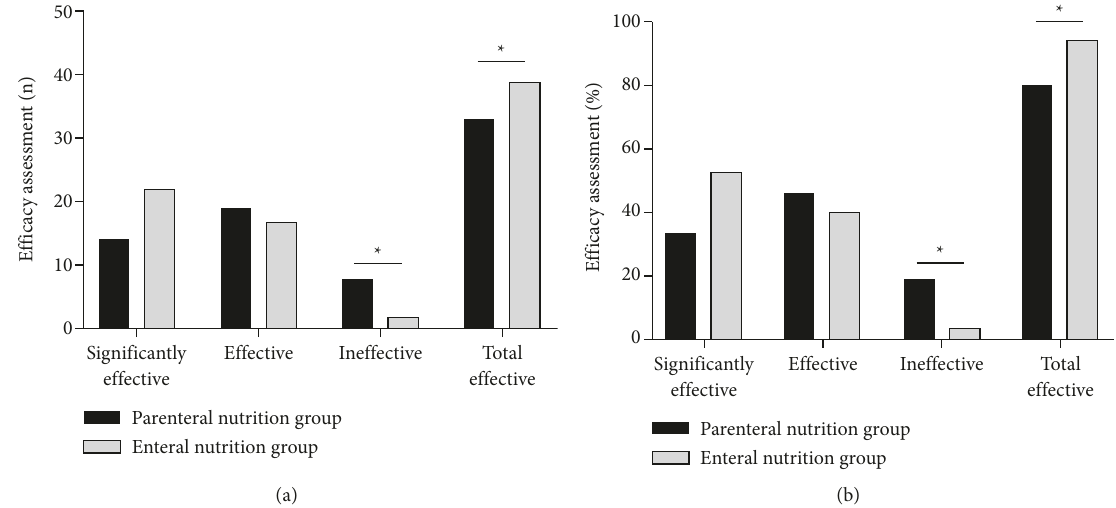
Figure 1: Comparison of efficacy assessment between the two groups. (a) Cases of efficacy assessments. (b) Percentage of efficacy as- sessments. There was a statistical difference between two ∗